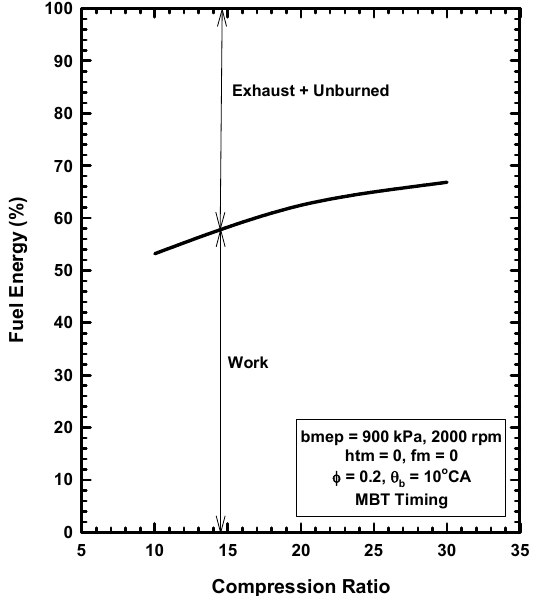
Figure A1. Partition of the fuel energy among work, exhaust, and unburned fuel as a function of compression ratio for the ideal conditions.